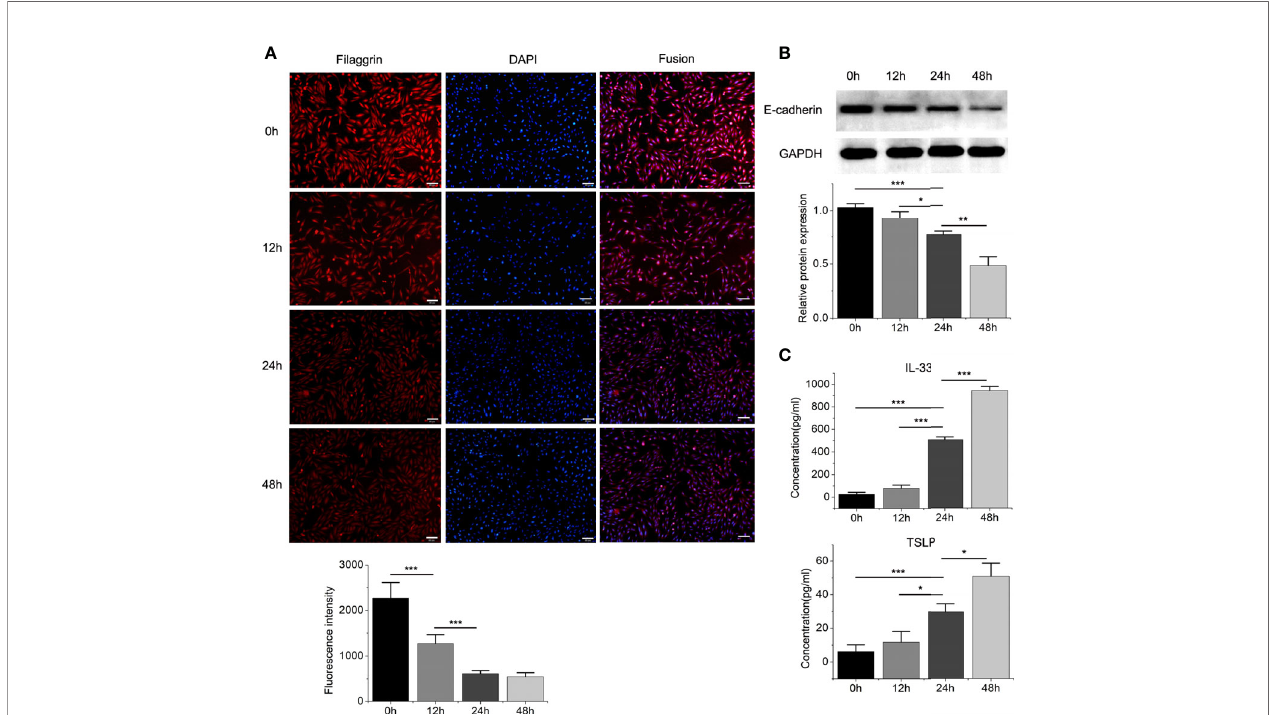
FIGURE 4 | The protein expressions of fi laggrin, E-cadherin, TSLP and IL-33 of BEAS-2B cells with IL-4 incubating for different periods. (A) The protein expression of fi laggrin in BEAS-2B cells treated with IL-4 for different periods was detected by Immuno fl uorescence. The photographs were magni fi ed of 200 times and the bars represented 50 m m. (B) The protein expression of E-cadherin in BEAS-2B cells treated with IL-4 for different periods was detected by Western-blot. (C) IL-33 and TSLP in the cell culture supernatants with IL-4 treatment for different periods were detected by ELISA. Each experiment has been repeated for 3 times and presented as the mean ± SD (n=3). The Student ’ s t-test was used to analyze the difference between groups. *P < 0.05 was considered as statistically signi fi cant. **P < 0.01, ***P < 0.005.